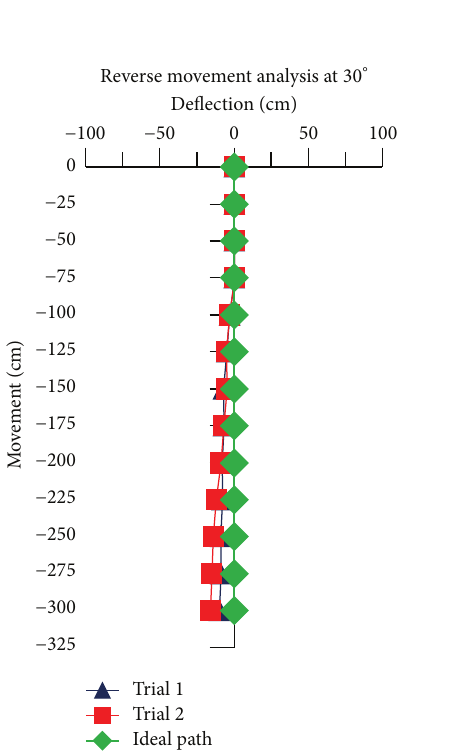
Figure 16: Real-time experiment of reverse movement analysis of TWOMR at 𝜃 = 45 ∘ .